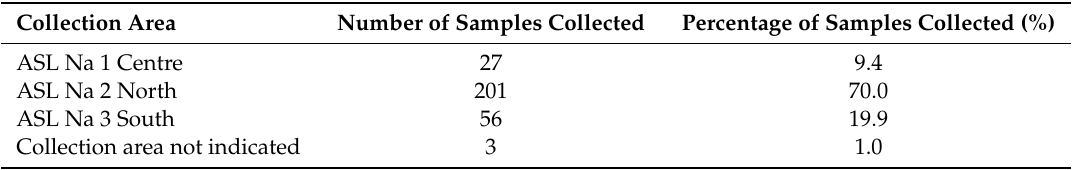
Table 1. Sample collection sites.